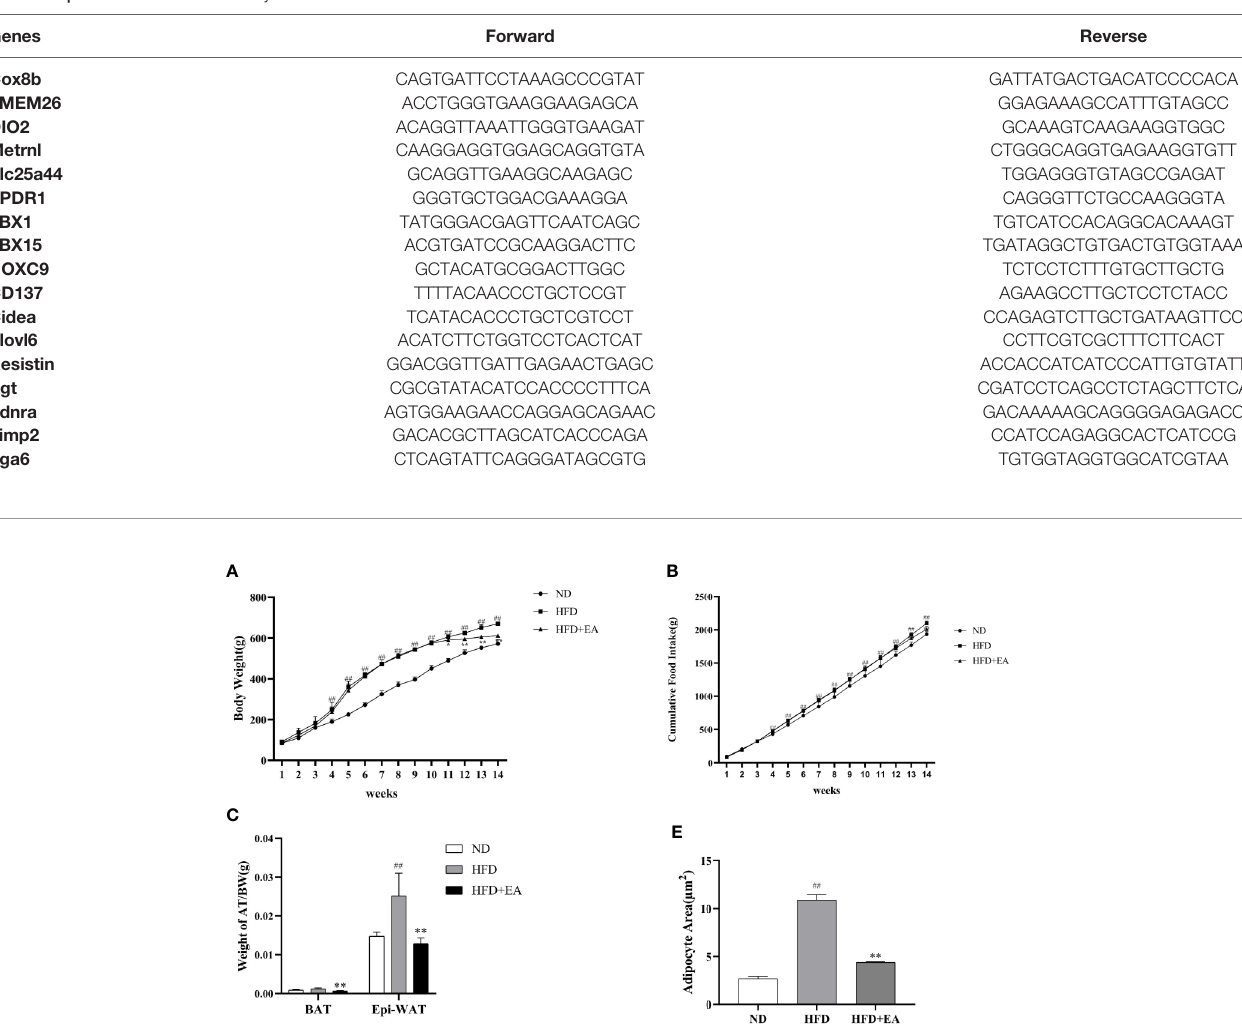
TABLE 2 | Primers used in this